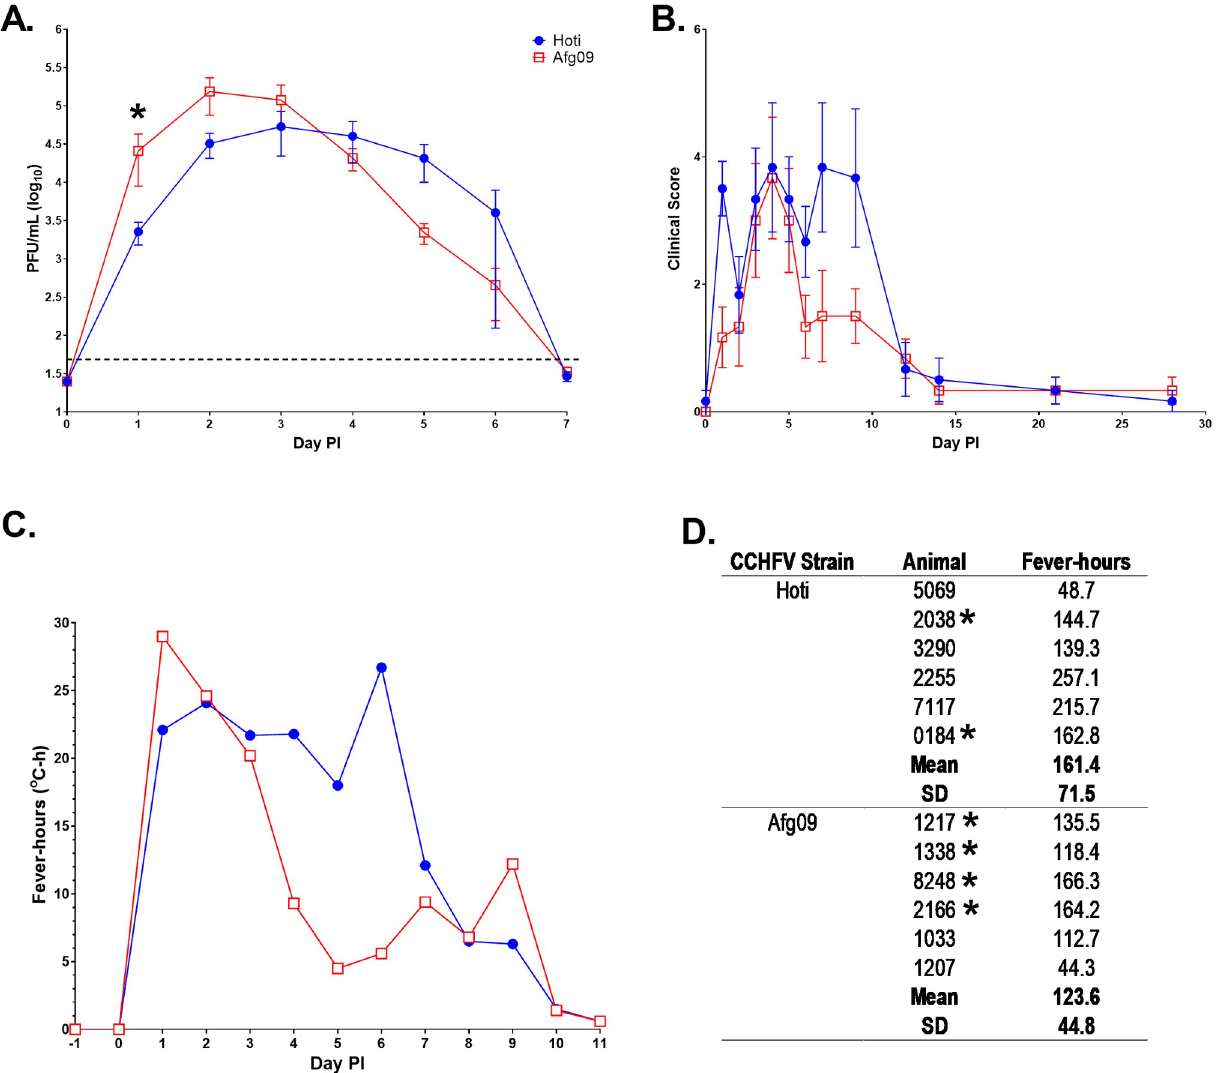
Fig 1. Viremia, clinical score, and fever responses in cynomolgus macaques infected IV with CCHFV strain Hoti or Afg09. A). Viremia was determined by standard plaque assay. The symbols represent the mean value and the error bars represent the standard error of the mean. The dashed line represents the assay LOD. The asterisk indicates a statistically significant difference in viremia was detected between the two groups by mixed model repeated measures ANOVA (p = 0.0045). B). Clinical scores were determined on each animal when anesthetized for blood collection. The symbols represent the mean value and the error bars represent the standard error of the mean. C). The significant temperature responses are indicated as fever- hours and shown for the animals infected with CCHFV strain Hoti or Afg09. D). The total fever-hours for each NHP with group means and SD. Asterisks indicate the NHPs that had evidence of a latent mycobacterial